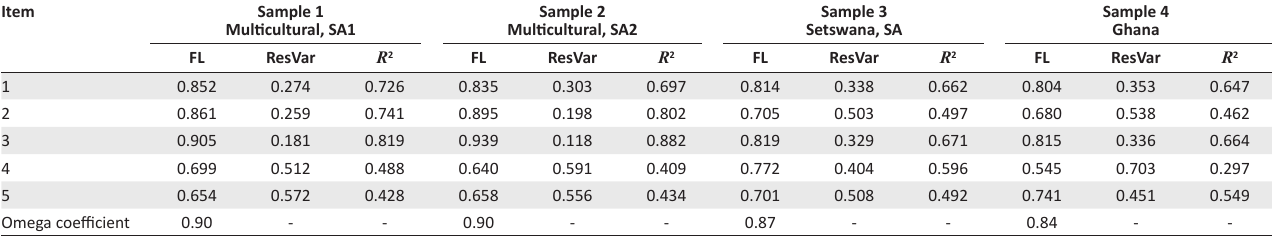
FL, factor loading; ResVar, residual variance; R 2 , proportion of variance explained by the factor; SA, South African; SA1, South African Sample 1; SA2, South African Sample